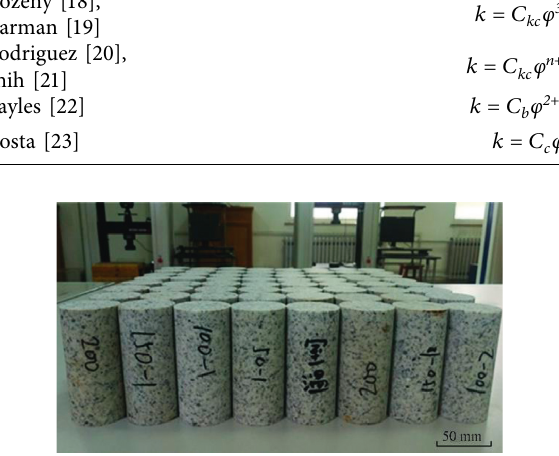
Figure 1: Rock specimen.